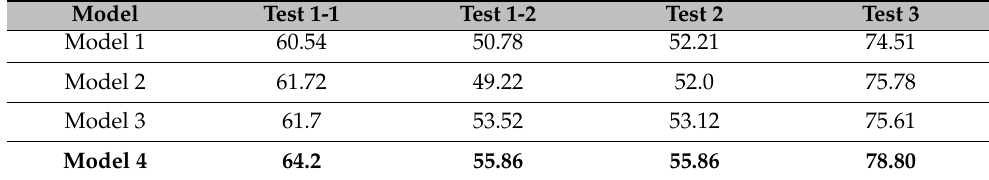
Table 6. Performance of the proposed and comparative